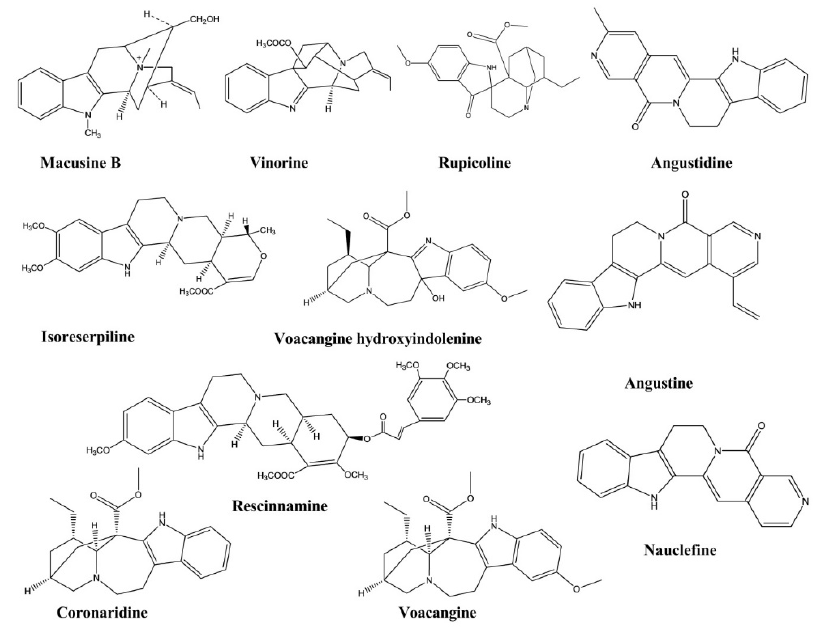
Figure 12. Anticholinesterase activity of Indole alkaloids.